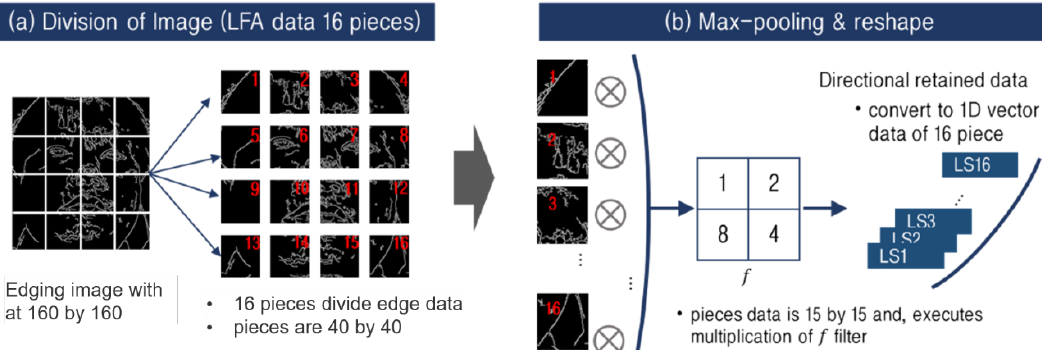
Figure 4. Driver facial contour-line data segmentation and line-segment type examination using 𝑓 : ( a ) Division of image (LFA data 16 pieces); ( b ) Max-pooling and reshape.